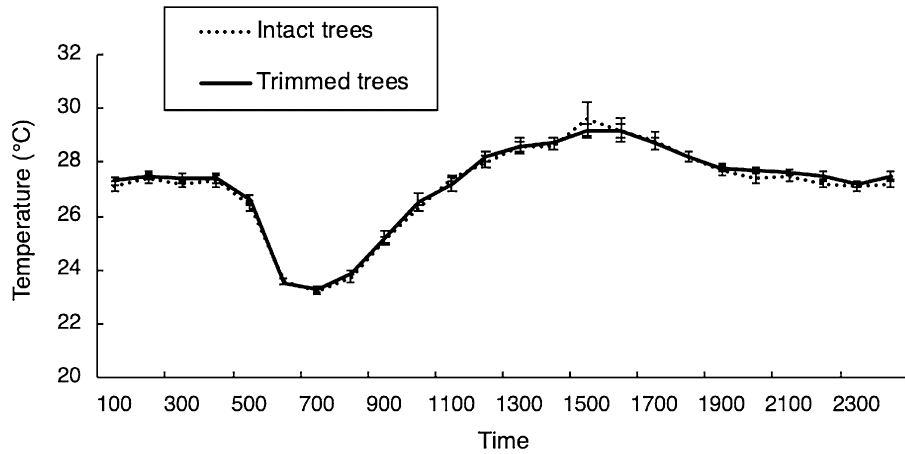
Figure 1. Hourly soil temperature measured under Chinee Apple trees with lower foliage removed (‘Trimmed’ n = 5) versus those that were left ‘Intact’ (n = 5). Temperatures were recorded over eight days during January. Data were pooled into three-hourly categories for analysis. Mean temperature changed significantly with time but did not differ between trimmed vs intact trees. Hourly temperatures are represented as the mean across all sites under either trimmed or intact trees, with error bars of one standard error from the